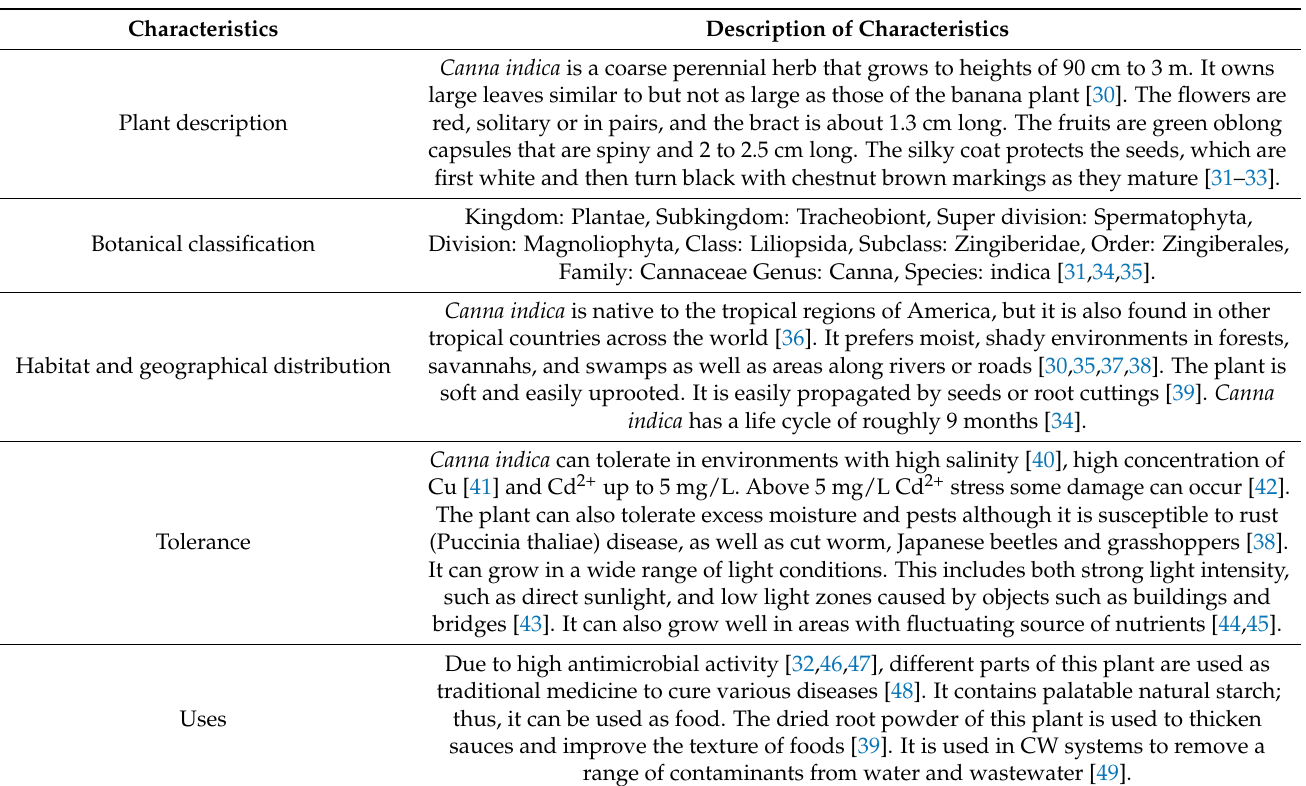
Table 1. Some characteristics of Canna indica